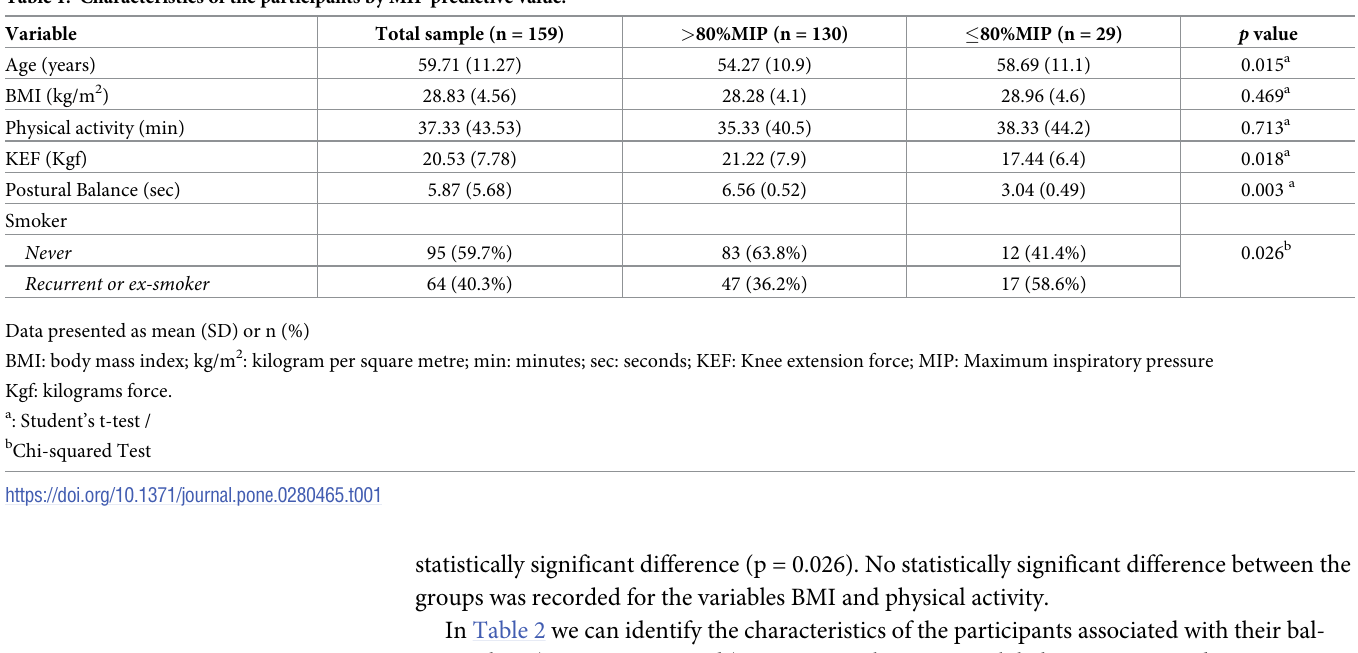
Table 1. Characteristics of the participants by MIP predictive value.